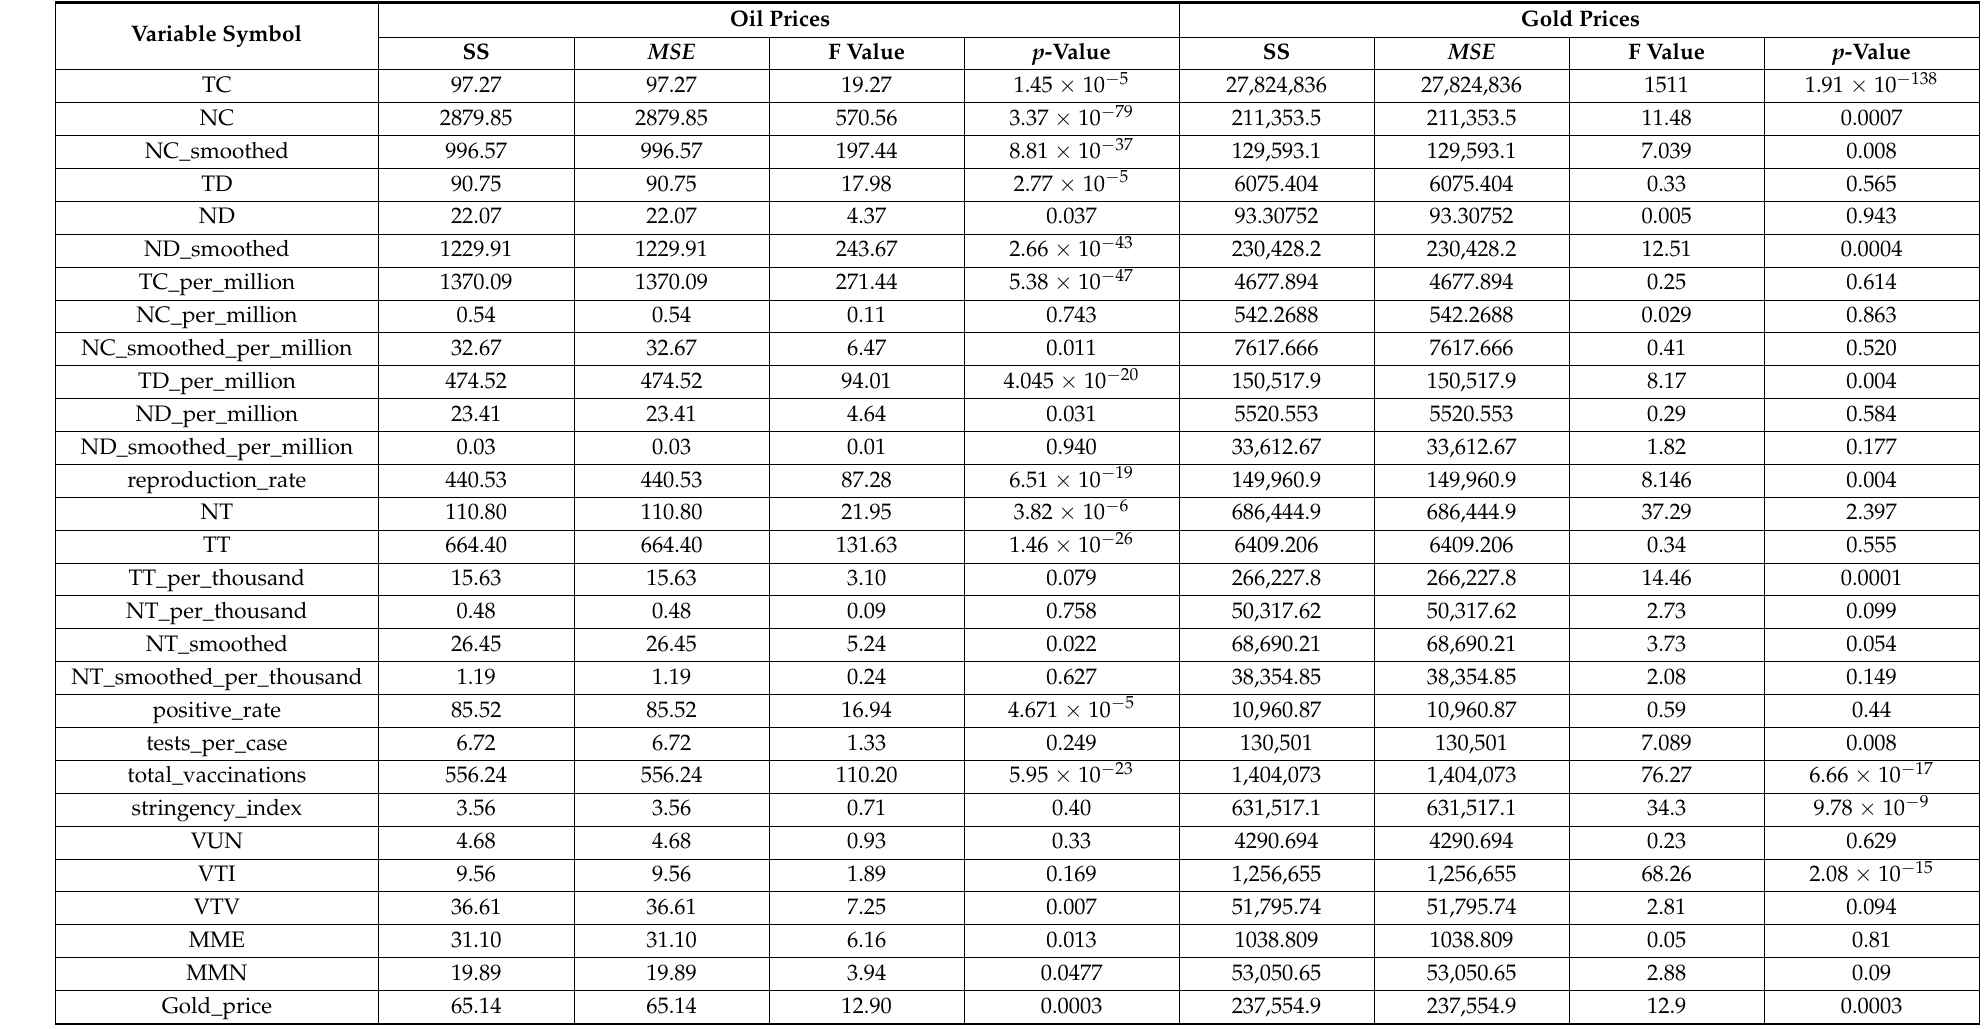
Table 2. ANOVA test for the oil/gold prices and the input